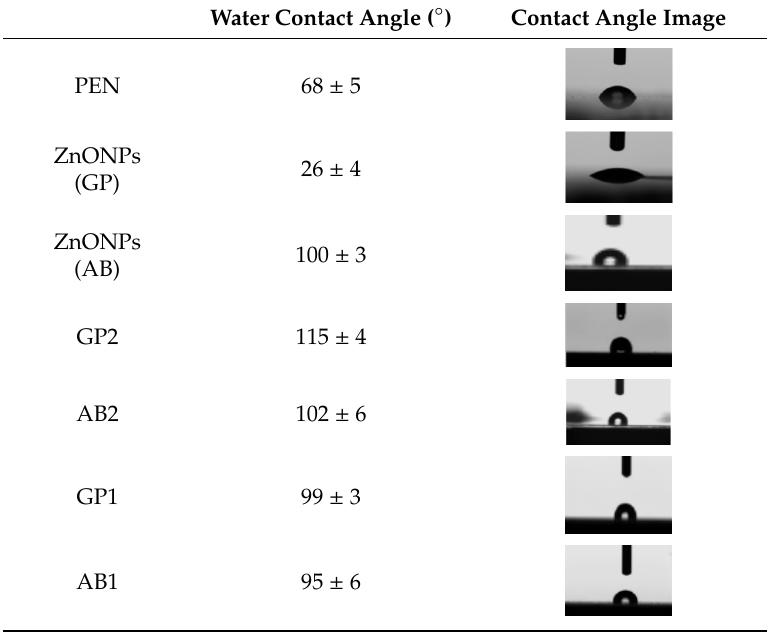
Figure 4. Scanning electron microscope (SEM) images of ZnONPs films obtained by gravure printing ( a ) and airbrushing ( b ), and ZnONPs/stearic acid coatings GP2 ( c ), AB2 ( d ), GP1 ( e ) and AB1 ( f ).